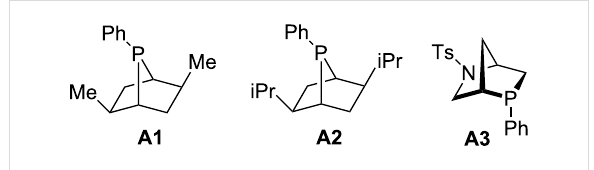
Figure 1: Cyclic chiral phosphines based on bridged-ring